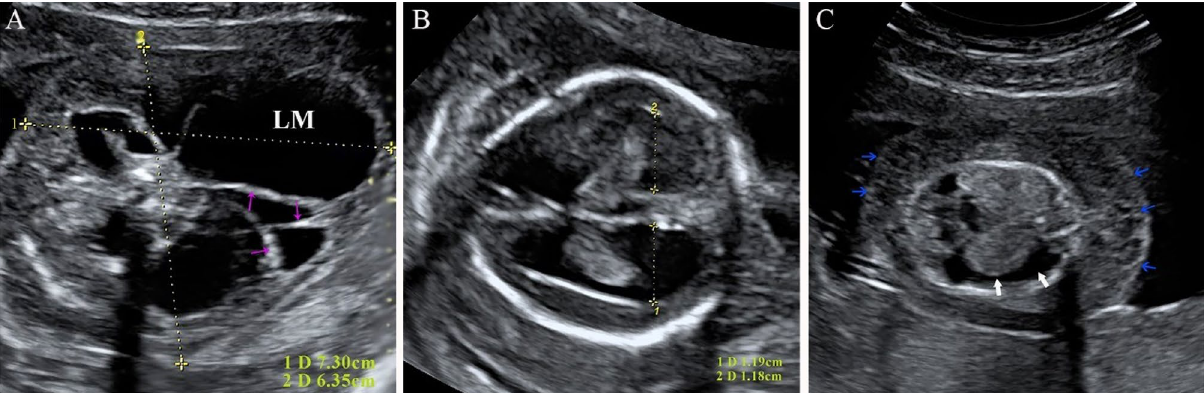
Figure 3. A lymphatic malformation (LM) at 17 weeks of gestational age. ( A ) Prenatal ultrasound exhibited a large anechoic lesion (7.3 × 6.35 cm) located at the back of the neck, and multiple intervals in the tumor can be identified. ( B ) The posterior horn of the right and left lateral ventricles were 1.18 cm and 1.19 cm, respectively. ( C ) Ultrasound of fetal chest showed a large pleural effusion (white arrow) and demonstrated severe fetal subcutaneous edema with low unevenness echo (blue arrow).